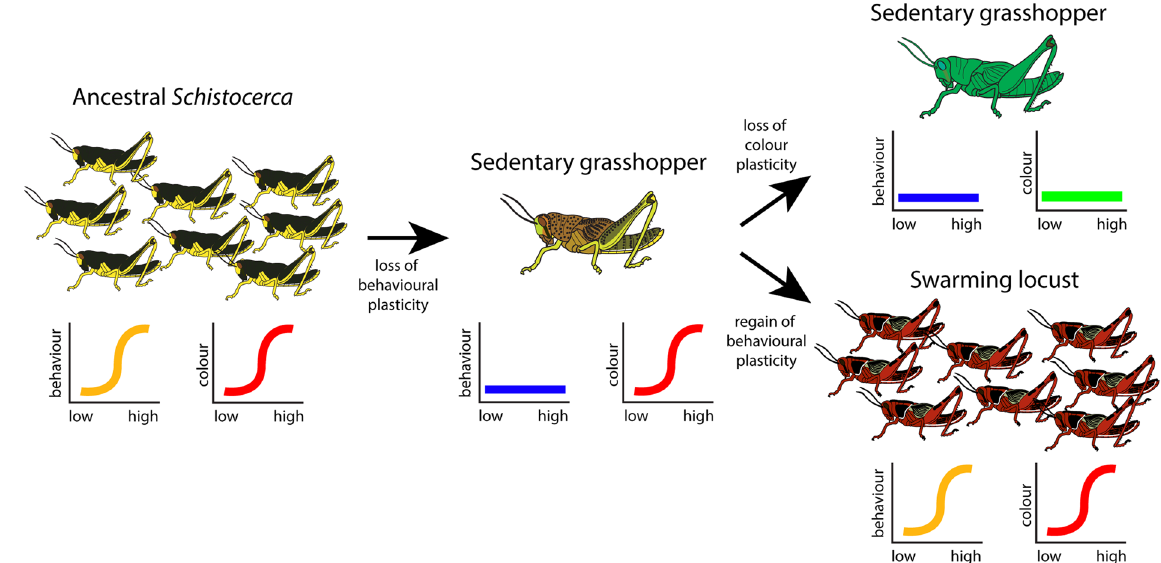
Figure 5. A graphical summary of evolution of density-dependent reaction norms as inferred from this study. The ancestral Schistocerca was a swarming locust and must have had plastic reaction norms in both behaviour and colour. However, behavioural plasticity was lost in the descendant species while colour plasticity was maintained. In some species, colour plasticity was lost and they have become completely non-responsive to density. There has been at least two independent re-gains of behaviour plasticity giving rise to two locust species in the New